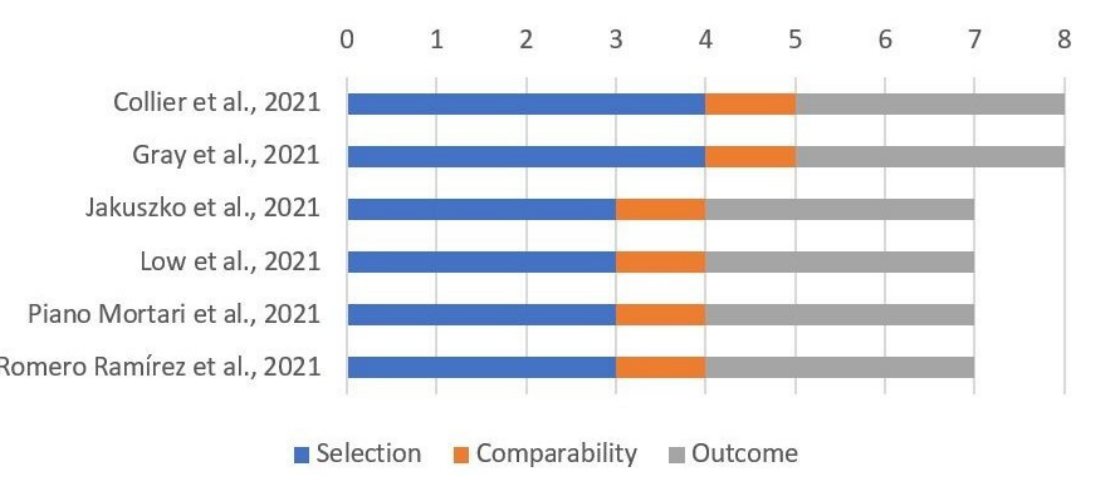
Figure 4. Quality assessment of included cohort studies involving breastfeeding mothers through “Newcastle–Ottawa Scale for cohort studies”.